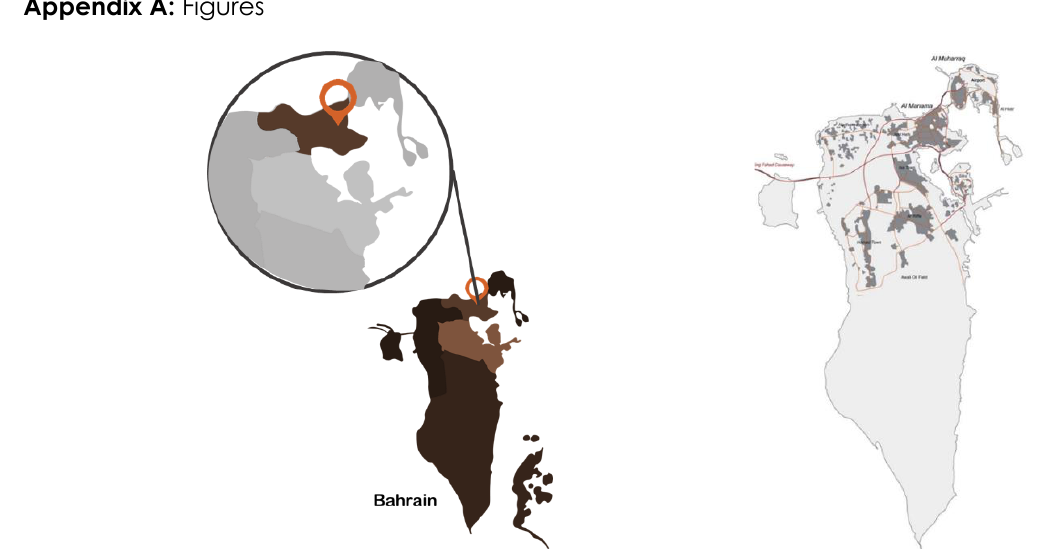
Figure 1: Principle springs of Bahrain (Al-Nabi, 2012) Figure 2: Settlement areas of Bahrain in 1996